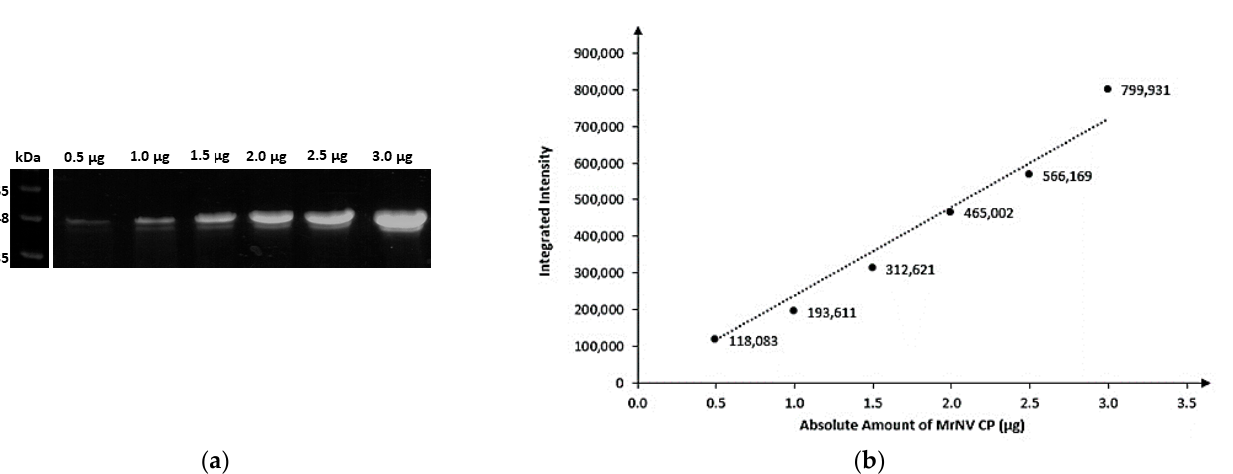
Figure 3. Generation of a standard curve based on the SDS-PAGE densitometric method. ( a ) Different amounts of MrNV CP (46 kDa) ranging from 0.5–3.0 µg/well on SDS-PAGE were stained with Coomassie Brilliant Blue (CBB) and quantitated with the ImageJ software [20]. The amounts of MrNV CP are labelled on top of the membrane. ( b ) A linear graph was plotted between the integrated intensity of the bands against absolute quantity of protein per well. The linear regression data are as tabulated in Table